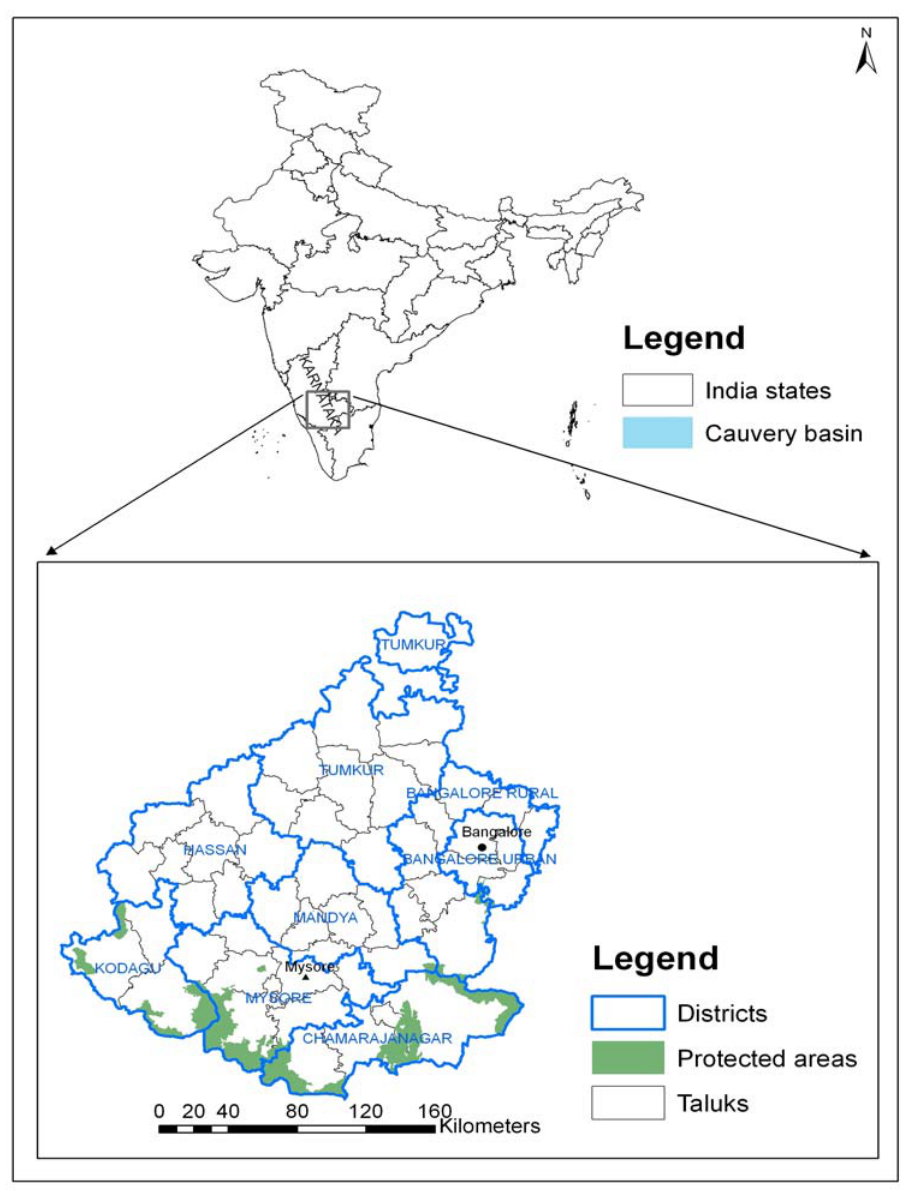
Figure 1. Study area, with protected area boundaries